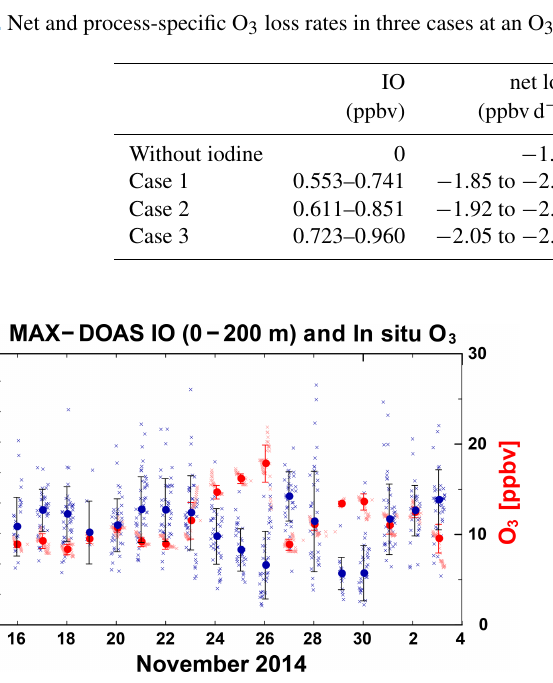
Figure 7. Time series of IO mixing ratio for 0–200m (blue; pptv) observed by MAX–DOAS, and in situ O 3 mixing ratio (red; ppbv). Circles and horizontal bars, respectively, represent the daily median and 1 standard